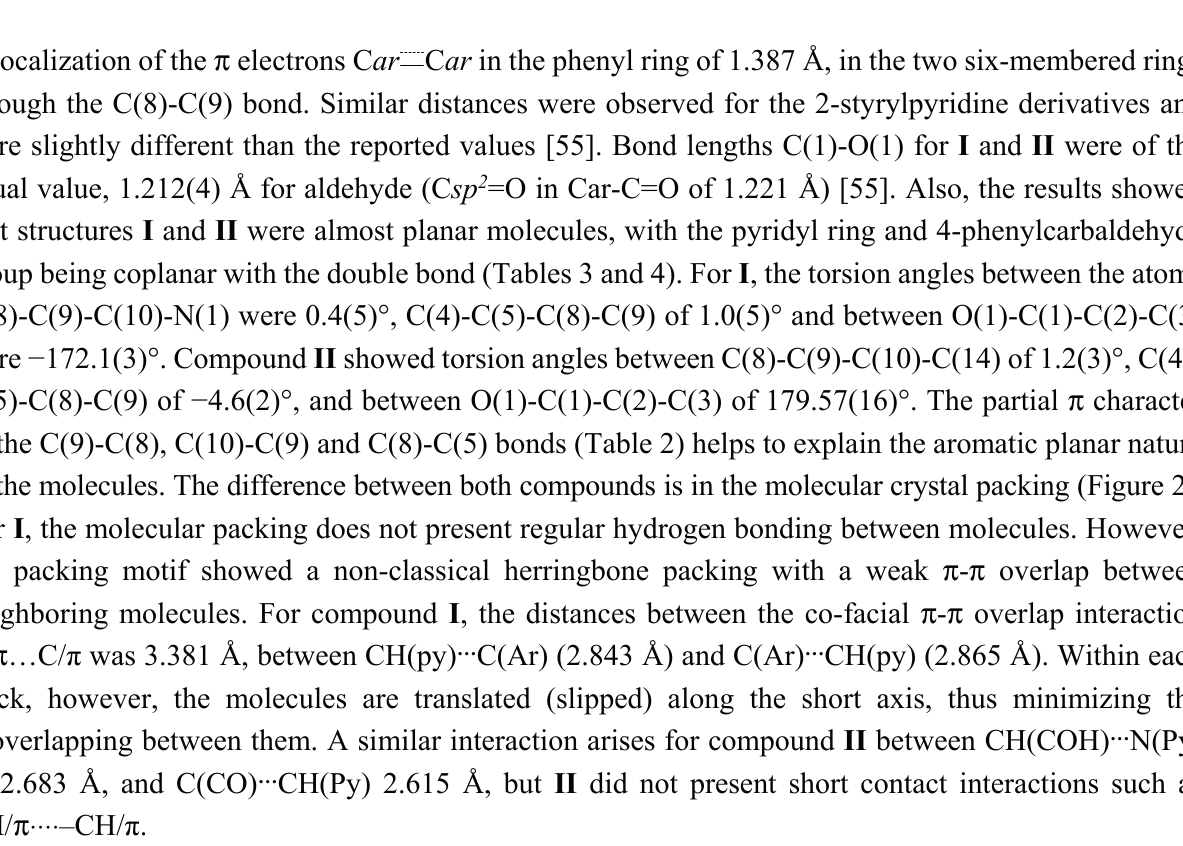
Table 3. Bond angles (°) for compounds I , II and III